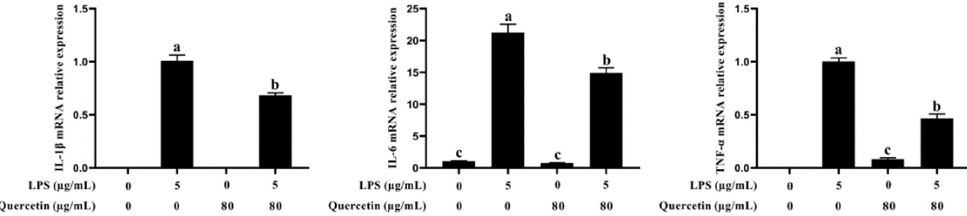
Figure 4. Impact of quercetin on the mRNA expression of pro-inflammatory cytokines (IL-1 β , IL-6, and TNF- α ) in LPS-induced BIECs. BIECs were treated with 80 μ g/mL quercetin in the involvement of 5 μ g/mL LPS for 6 h. The mRNA expressions of IL-1 β , IL-6, and TNF- α in BIECs were examined by qRT-PCR. The results are mean ± SEM (n = 6). Various lowercase letters in the line graph demonstrate significant changes ( p < 0.05).